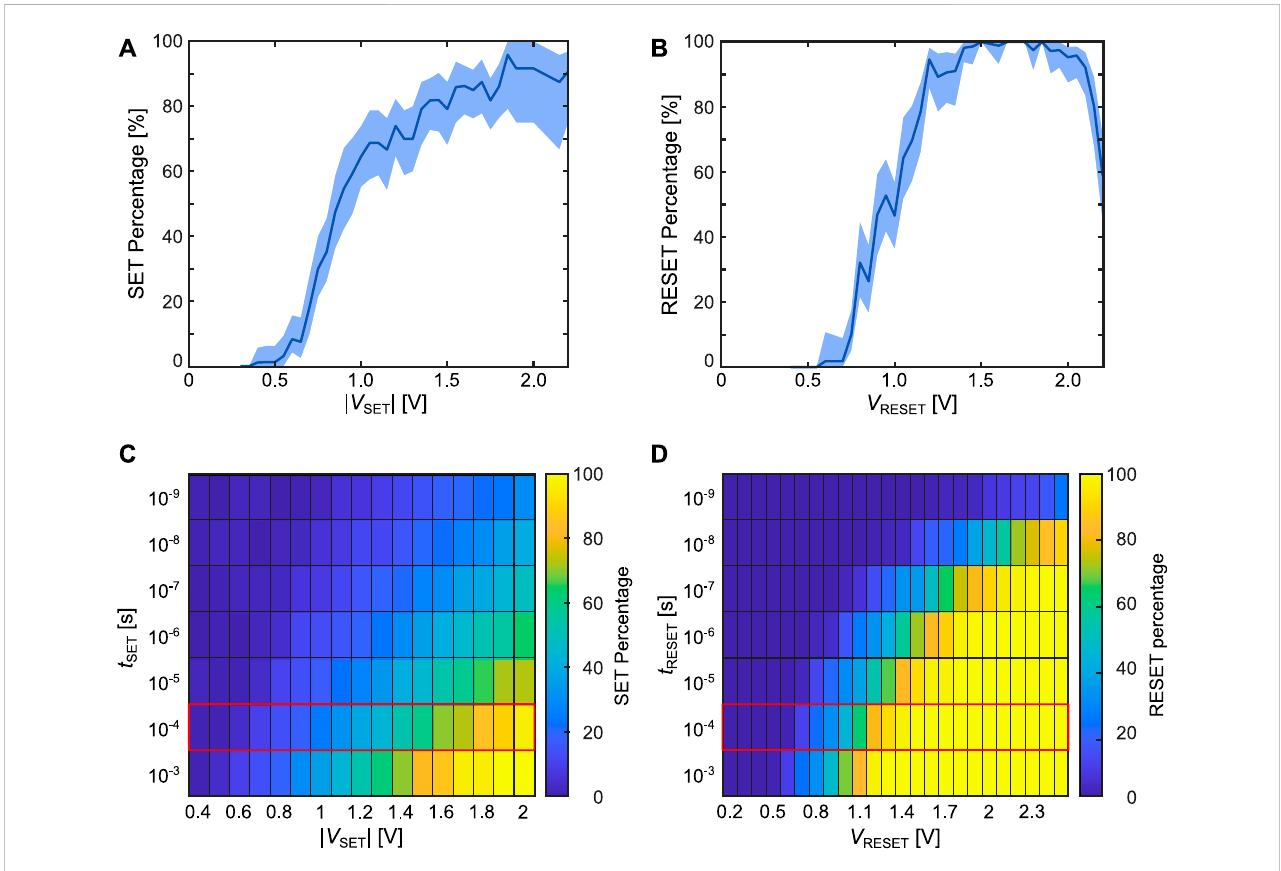
FIGURE 8 (A, B) show the experimental SET and RESET percentages for different applied voltages. The shaded area indicates a 95% con fi dence interval for the probabilities. The experiments where done for a pulse length of 100 μ s. (C, D) show the simulated SET and RESET percentages for a range of pulse durations and different voltages as a heat map. The red rectangles around the 100 μ s indicate the same pulse length as in the